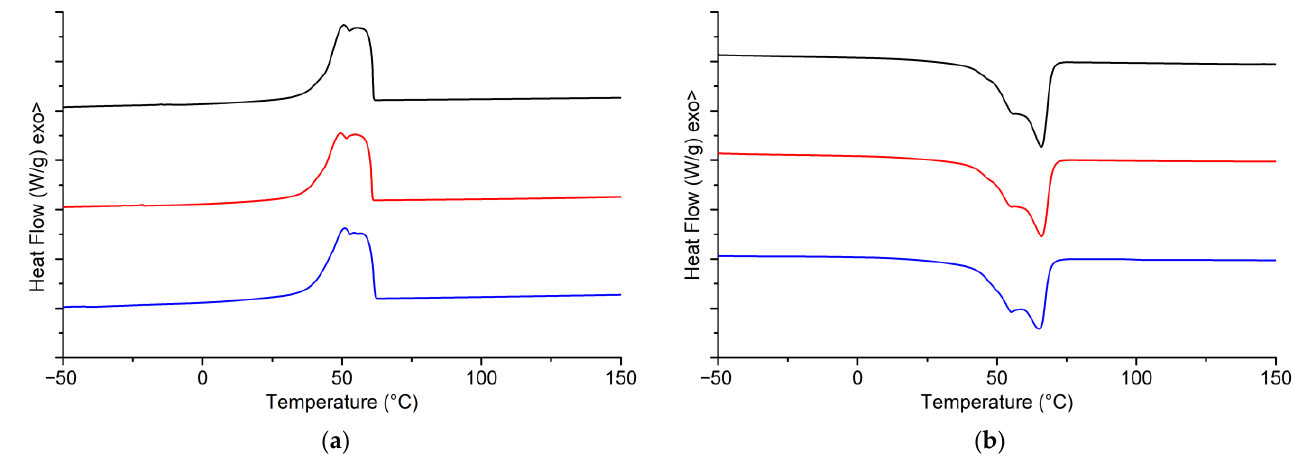
Figure 6. DSC thermograms of adhesive 1 (black), adhesive 2 (red), and commercial beeswax (blue): ( a ) Cooling run and ( b ) Heating run.